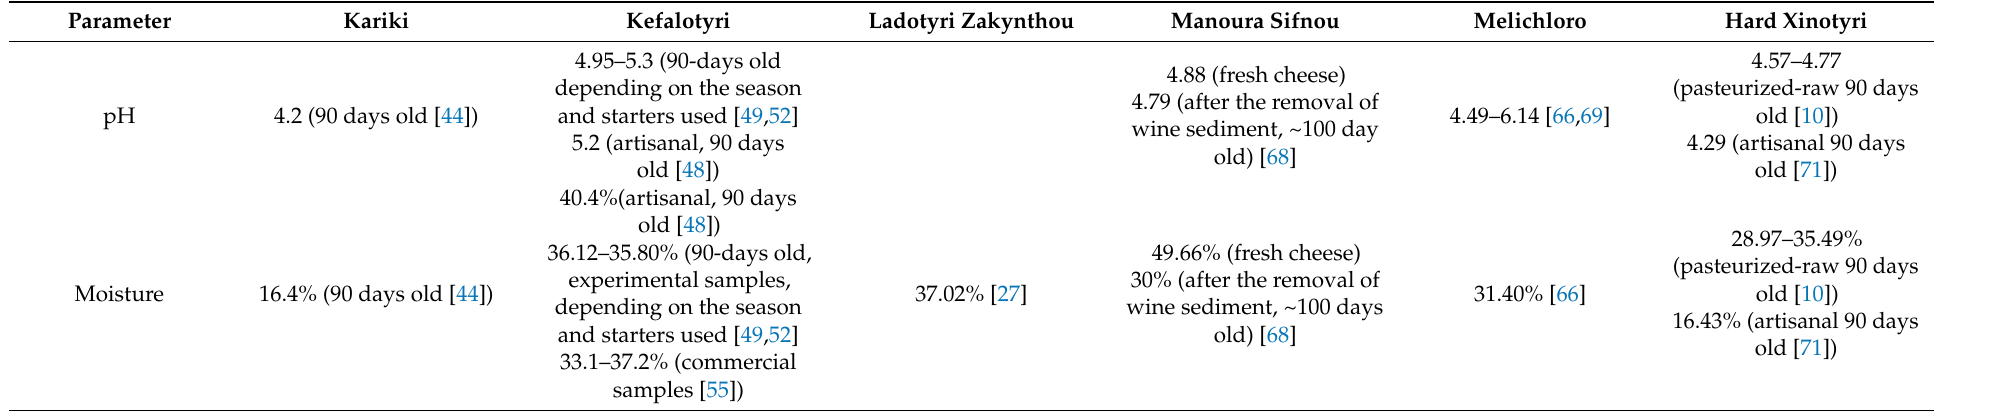
Table 3. Composition of nonprotected designation of origin and nonprotected geographical indication hard